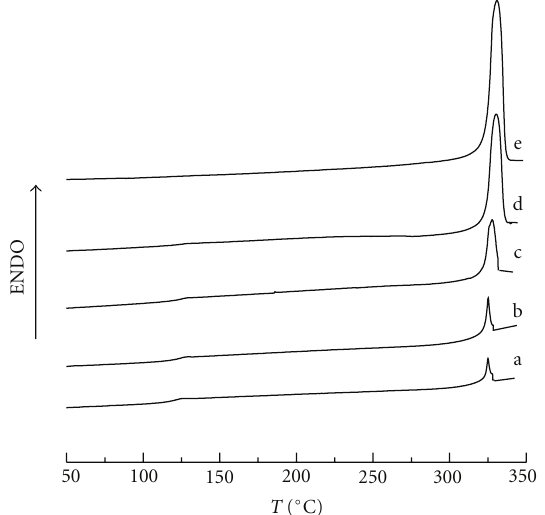
Figure 5: DSC second heating at 10 ◦ C/min of samples: BPM4 (a), BPM5 (b), BPM7 (c), BPM11 (d), and BP44 (e).